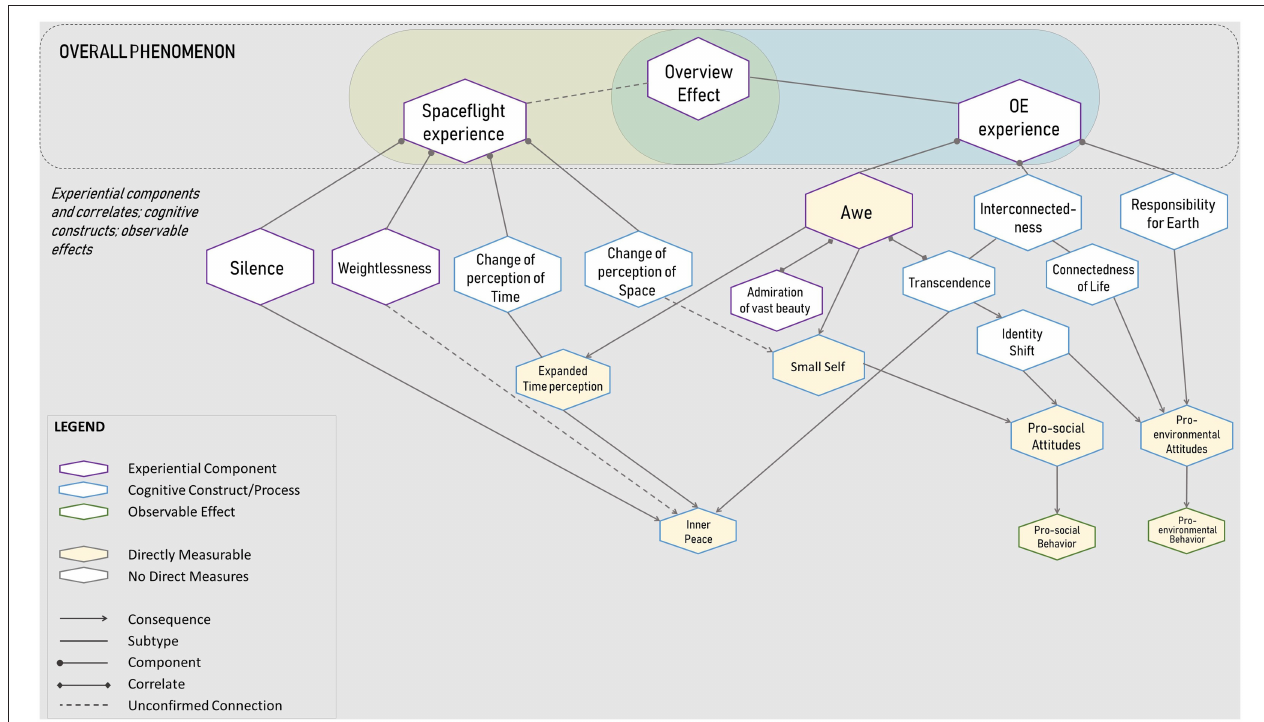
FIGURE 3 | Schematic illustration of the cognitive constructs and outcomes of the Overview Effect. The OE is traditionally described in the context of an actual spaceflight, but the experience of the OE, in principle, might be a phenomenon that could be experienced in a different context as well. Therefor some aspects of a spaceflight might be crucial for the OE experience to occur, while others might be irrelevant.